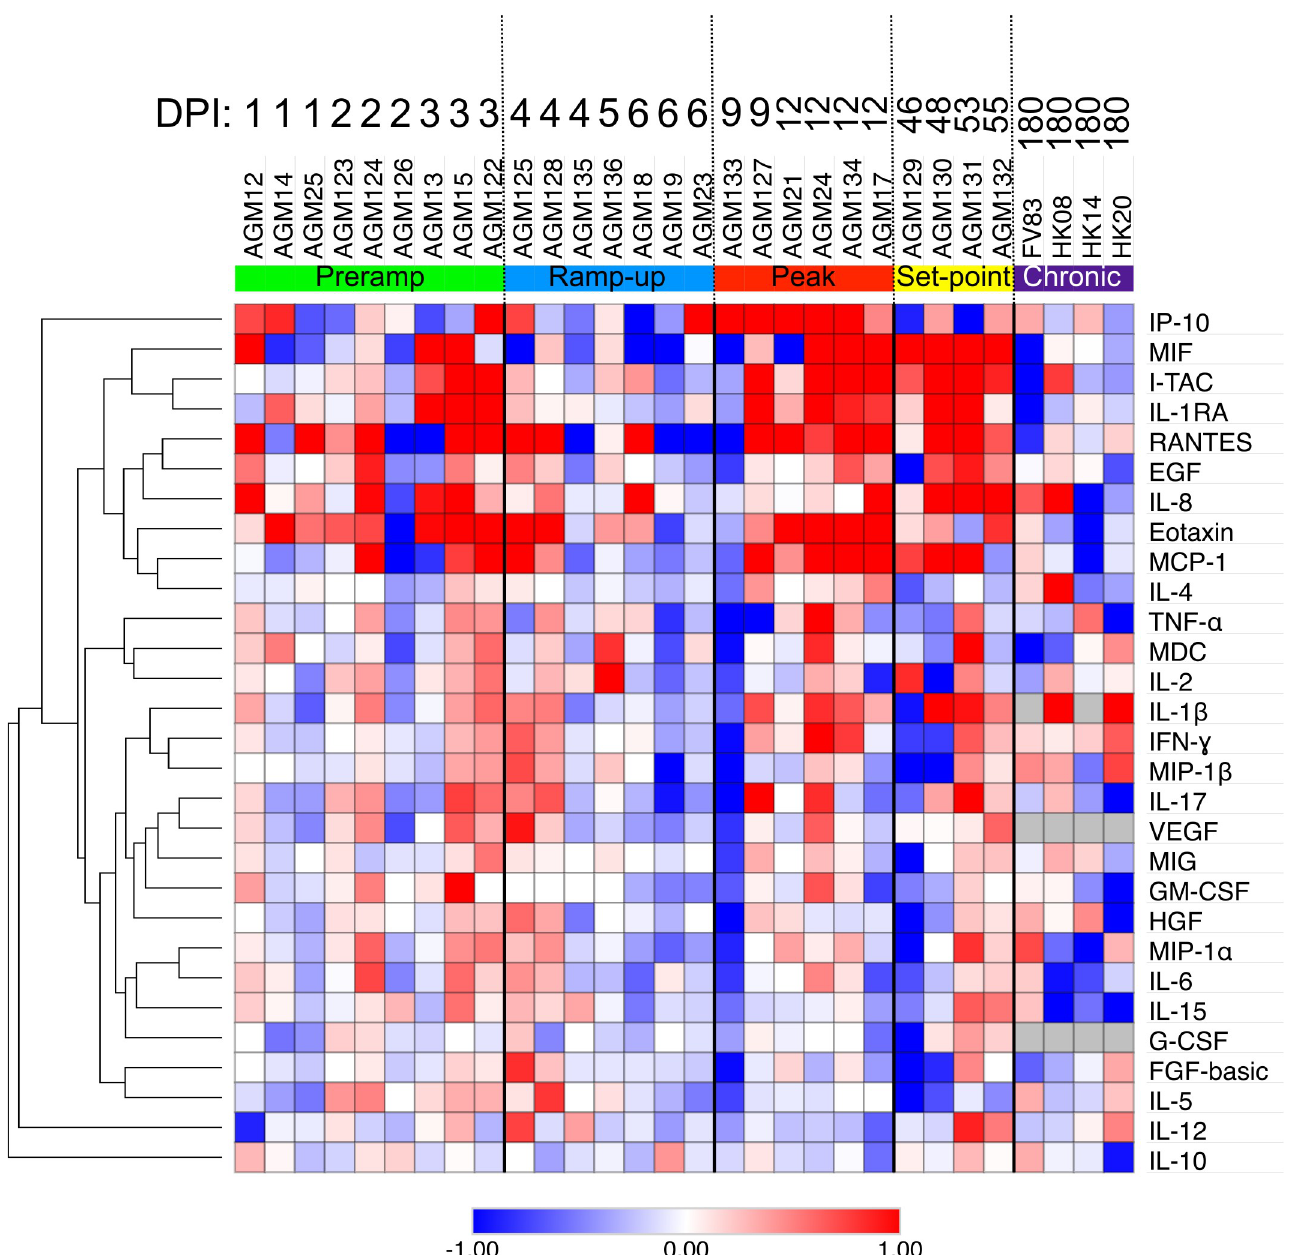
Fig 4. Heatmap of cytokine fold changes from baseline following intrarectal SIVsab infection of AGMs. Colors represent the fold change from preinfection to postinfection of the cytokines for each of the AGMs. Red indicates a positive fold change, while blue represents a negative fold change, with color intensity being proportional to the magnitude of the fold change, as shown below the heatmap. Animal numbers are shown above the heatmap along with dpi, with the colors below the numbers highlighting their time groups: orange (baseline), green (preramp), blue (ramp-up), red (peak), yellow (set-point), purple (AGM historical controls, late chronic). Cytokines and chemokines are listed on the right side of the heatmap. The results are clustered using a Spearman correlation, with the dendrogram showing relationship displayed on the left. The fold changes for the cytokines and chemokine levels were normalized with a log 2 transformation. The heatmap was generated using the publicly available Morpheus software (Broad Institute).